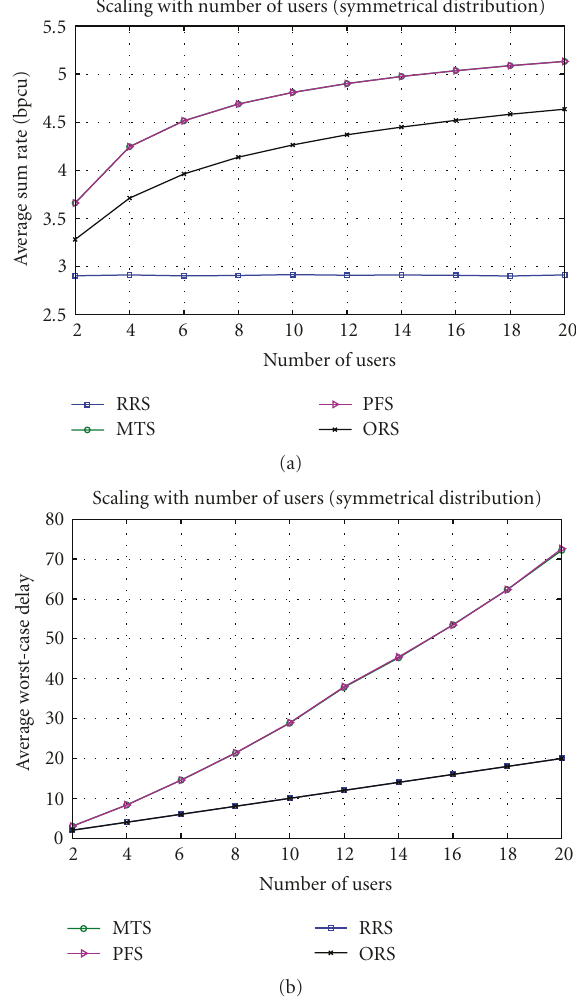
Figure 2: Average sum rate and worst-case delay versus number of users for symmetrically distributed